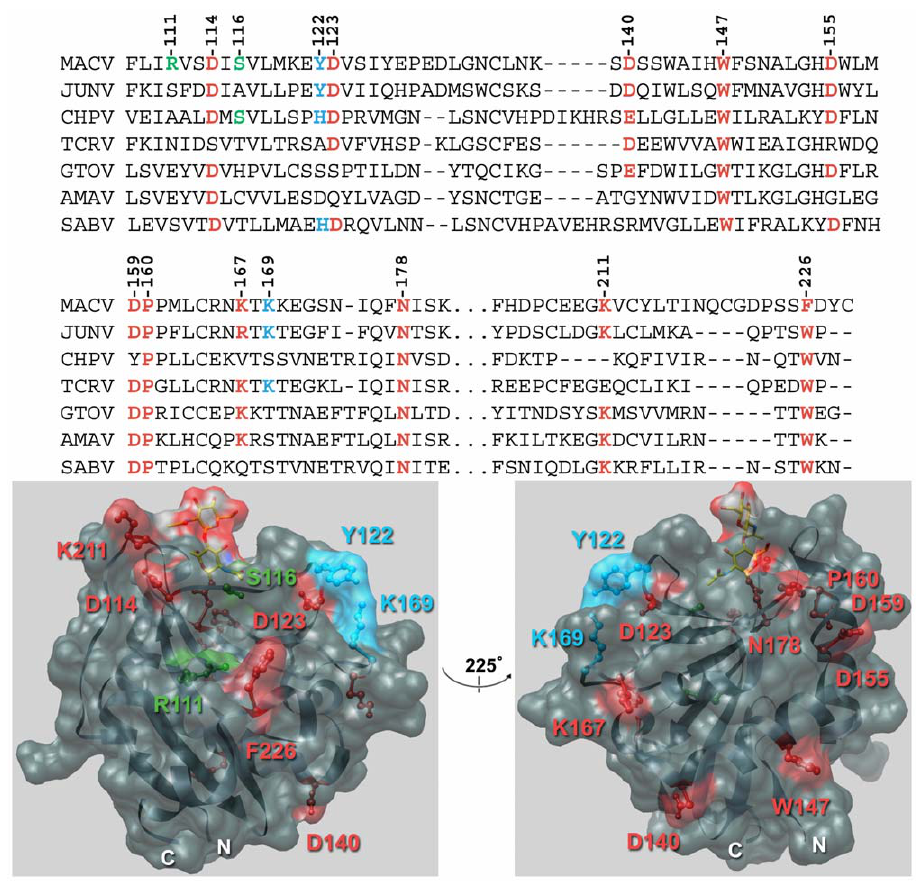
Figure 1. Machupo virus GP1 mutants. Top panel, sequence alignment of New World clade B arenaviruses. Sequence alignment of Machupo virus (MACV) GP1 residues 108–229 with Junı´n virus (JUNV), Chapare virus (CHPV), Tacaribe virus (TCRV), Guanarito virus (GTOV), Amapari virus (AMAV) and Sabia´ virus (SABV) GP1. Chosen residues for mutational analyses are indicated in bold red (conserved), bold blue (partially conserved), and bold green (nonconserved). GenBank Accession numbers for reference sequences are: AMAV, BeAn 70563 (AF512834); CHPV, 810419 (EU260463); GTOV, INH-95551 (AF485258); JUNV, MC2 (D10072); MACV, Carvallo (AY619643); SABV, SPH114202 (U41071); TCRV, (M20304). Bottom panel, structure of MACV GP1 fragment 87–239 [6], orientated with the N- and C-termini to the bottom (PDB ID number: